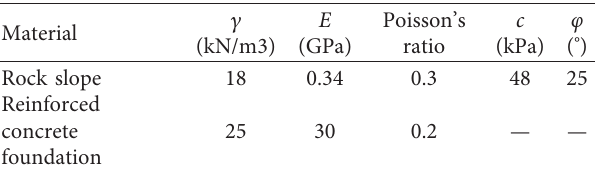
Figure 8: A 3D mesh for the half-model of a � 2.1 m, h � 3 m, and β � 45 ° . Table 5: Basic physical and mechanical parameters of rock and reinforced concrete.